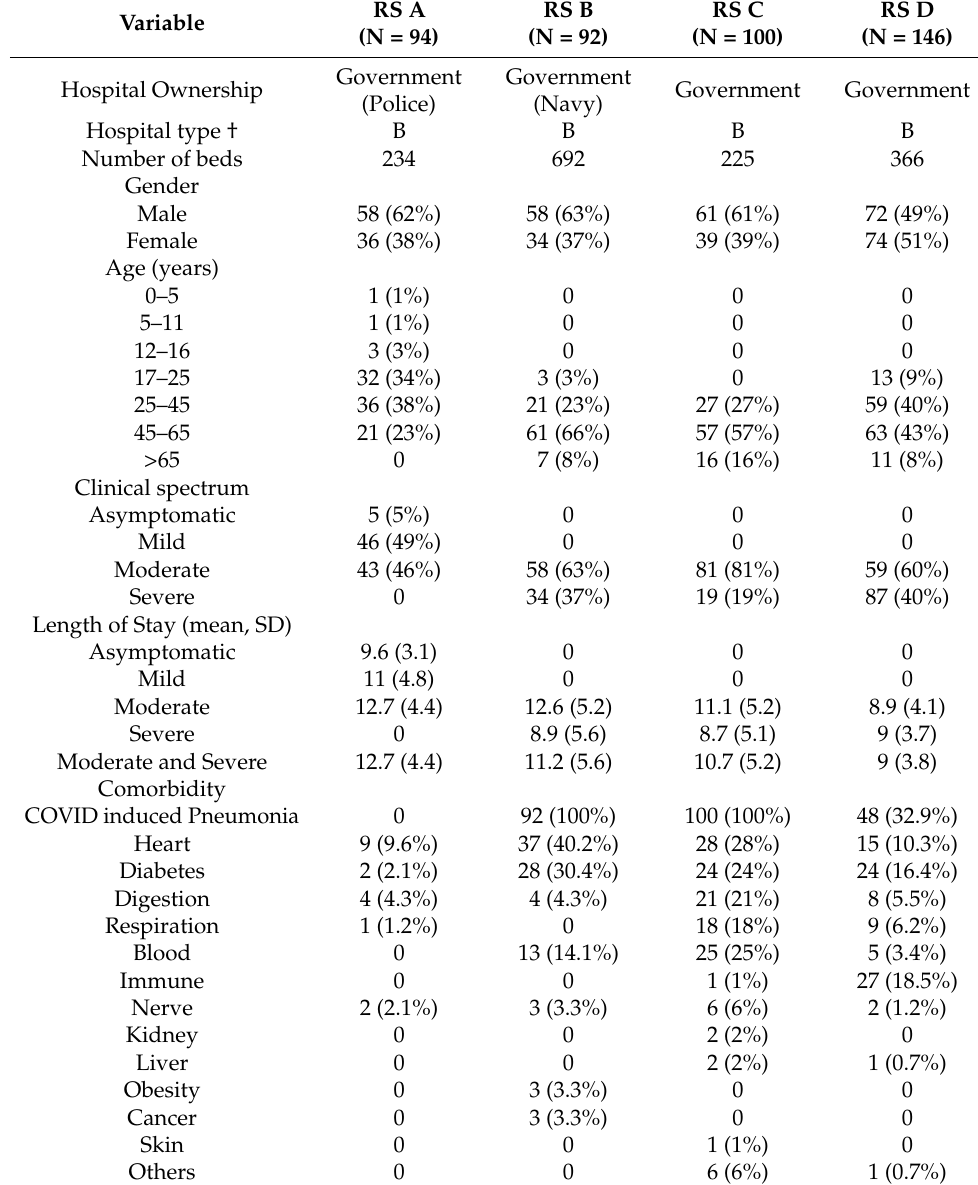
Table 1. Baseline demographic inpatient